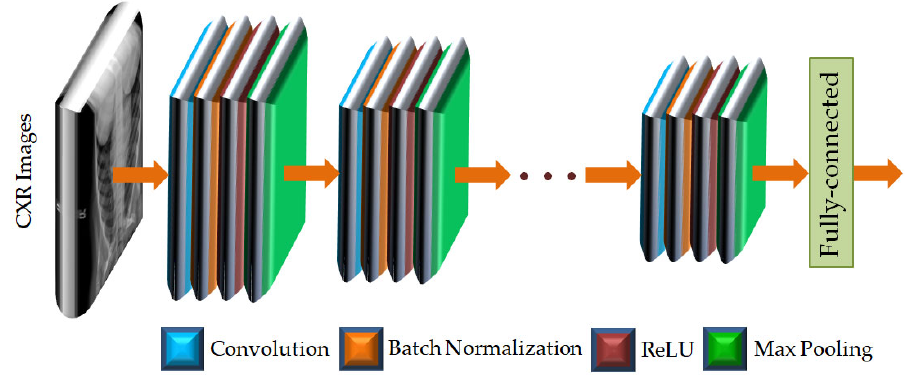
Figure 4. The layered architecture of a general CNN.